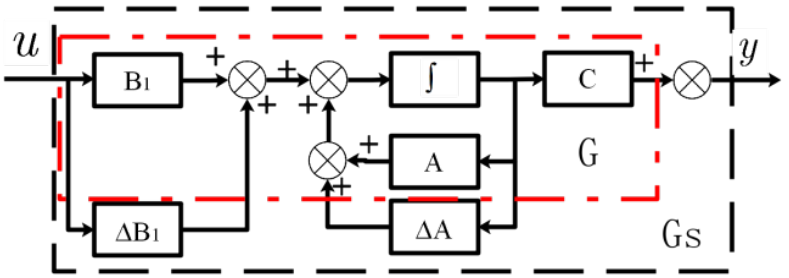
Figure 3. The uncertainty block diagram of the wind power system. 3. Analysis of Subsynchronous Resonance in a PMSG-Based Wind Farm